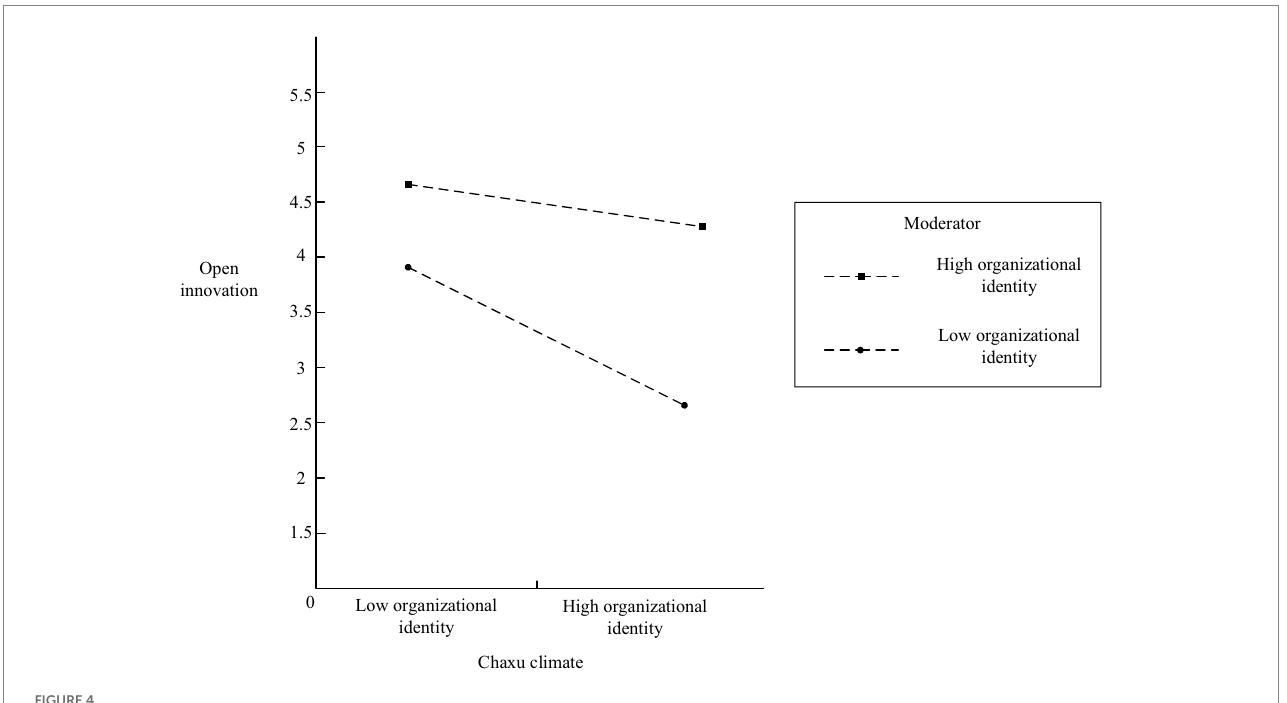
FIGURE 4 Moderating effect of organizational identity on organizational disorder climate and open